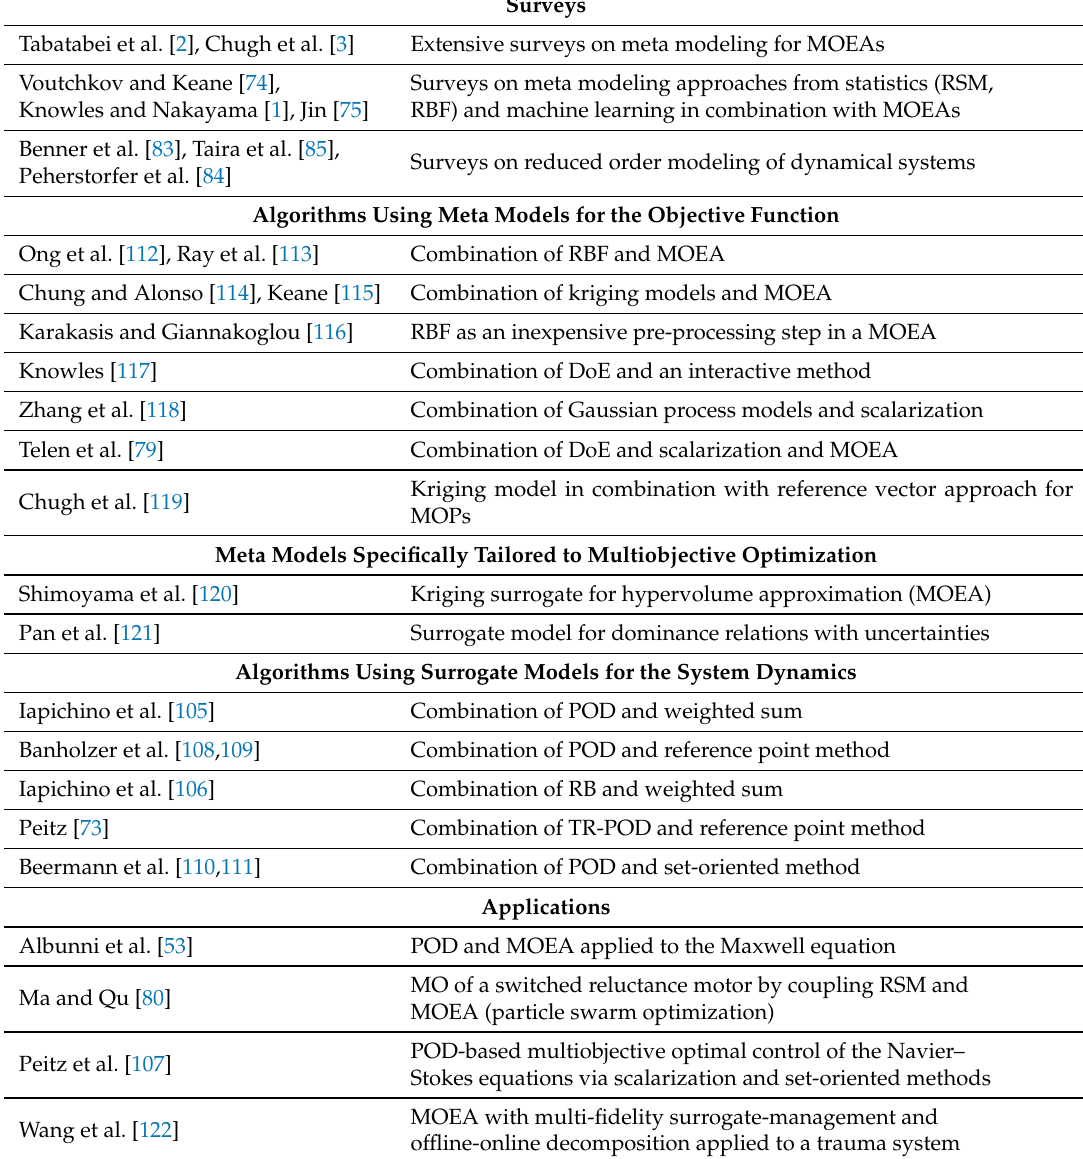
Overview of publications (in chronological order) where surrogate modeling and multiobjective optimization are combined. MOEA, Multiobjective Evolutionary Algorithm; RSM, Response Surface Model; POD, Proper Orthogonal Decomposition; TR, Trust